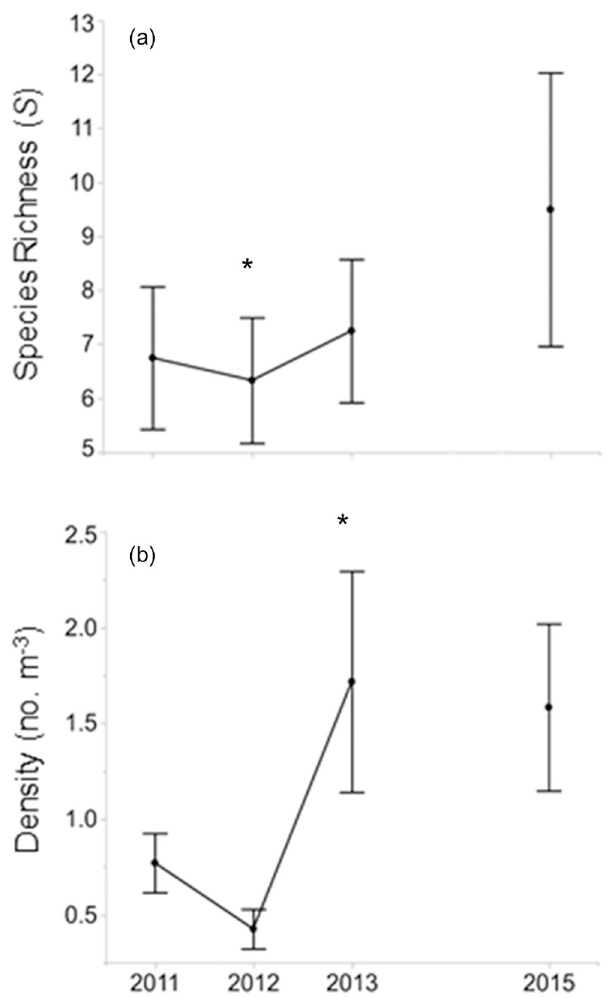
Fig 4. Line graphs of fish assemblage variables by year. Average values +/- 1 SE for the two fish assemblage variables showing significant differences between years at the 12 study reaches from 2011–2013, and in 2015 (four sites only: (a) species richness ( S ) (b) density (no. m -3 ). Asterisk indicates year that was significantly different. positive relationship between Johnny Darter ( Etheostoma nigrum ) relative abundance and sin- uosity as well as between Banded Darter ( Etheostoma zonale ), Brown Bullhead ( Ameiurus neb- ulosus ), Variegate Darter ( Etheostoma variatum ), Largemouth Bass ( Micropterus salmoides ), and Bluntnose Minnow ( Pimephales notatus ) relative abundances and slope and incision ratio (Fig 5a). The latter group contains species known to be insectivores, with some species (e.g., Largemouth Bass) transitioning to piscivores at larger sizes [79]. The 2012 CCA had a primary axis explaining 27.4%, and a secondary axis explaining 13.4%, of the variation in hydrogeomorphic characteristics. In contrast to the 2011 CCA, in 2012 Johnny Darter relative abundances were negatively associated with discharge, entrench- ment ratio, and width-of-floodprone area, while relative abundances of White Sucker, Orange- throat Darter ( Etheostoma spectabile ), Sunfish Hybrids ( Lepomis cyanellus × L . macrochirus ), and Green Sunfish were positively associated with incision ratio (Fig 5b). Within the latter group, all species are insectivores with the exception of White Suckers, and all are pollution-